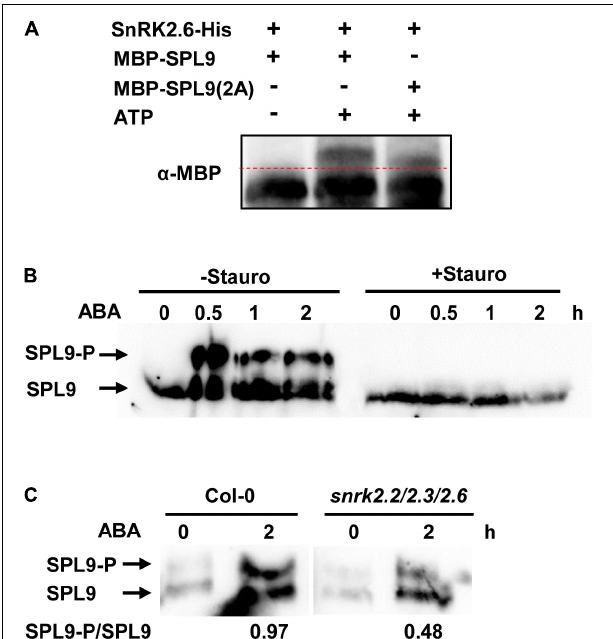
FIGURE 5 | SnRK2.6 phosphorylates SPL9 in vitro and in vivo . (A) In vitro kinase assays for the SPL9 protein by SnRK2.6 using phos-tag gel. The mutated SPL9 S 203 A , S 281 A protein is abbreviated as SPL9(2A). Proteins were detected by immunoblotting with anti-MBP antibody. (B) In vivo phosphorylation assays for SPL9 using phos-tag gel. The 6-day-old GFP-rSPL9 seedlings were treated with 50 µ M ABA and without or with 5 µ M Staurosporine for indicated times. Proteins were analyzed by immunoblotting with anti-GFP antibody. Stauro, Staurosporine. (C) In vivo phosphorylation assays for SPL9 in indicated genotypes using phos-tag gel. The 6-day-old GFP-rSPL9 and GFP-rSPL9 / snrk2.2 / 2.3 / 2.6 seedlings were treated without or with 50 µ M ABA for 2 h. Proteins were analyzed by immunoblotting with anti-GFP antibody. The arrows in (B) and (C) indicate the phosphorylated or unphosphorylated